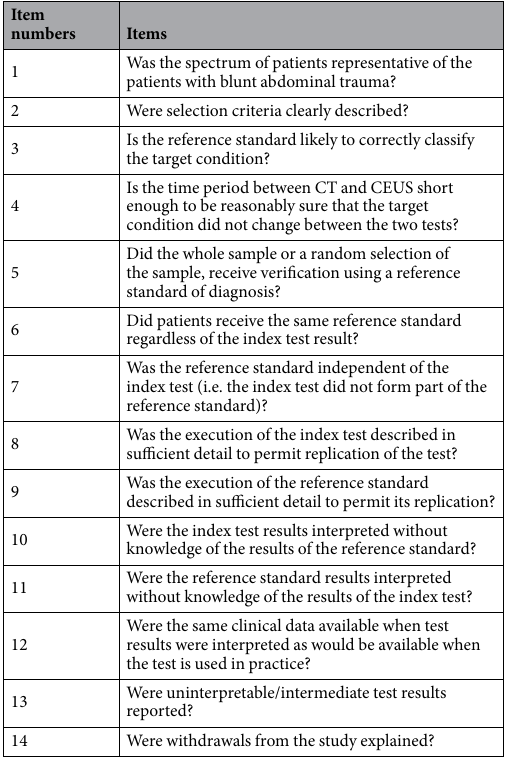
Table 1. The QUADAS tool items and their corresponding